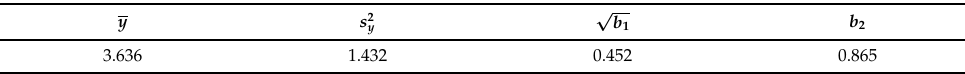
Table 6. Descriptive statistics of the ploidy dataset